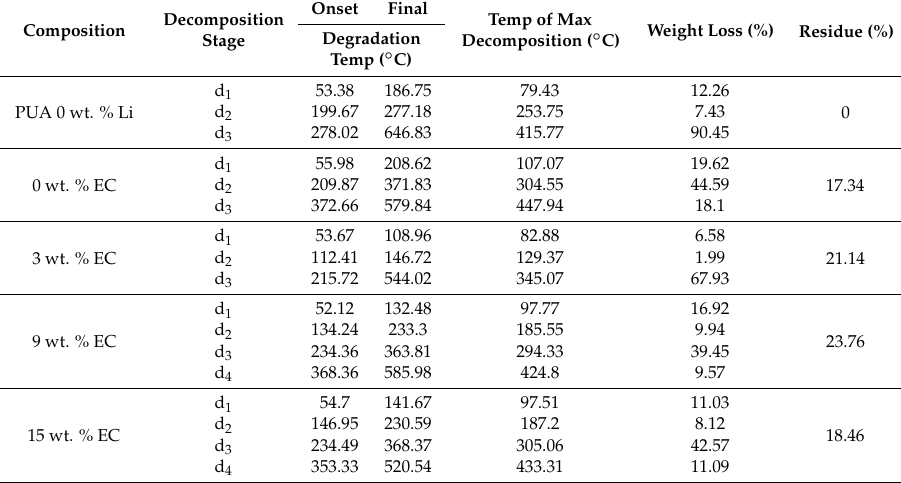
Table 3. Analysis of TG and DTG of PUA and PUA/LiClO 4 /EC electrolytes.